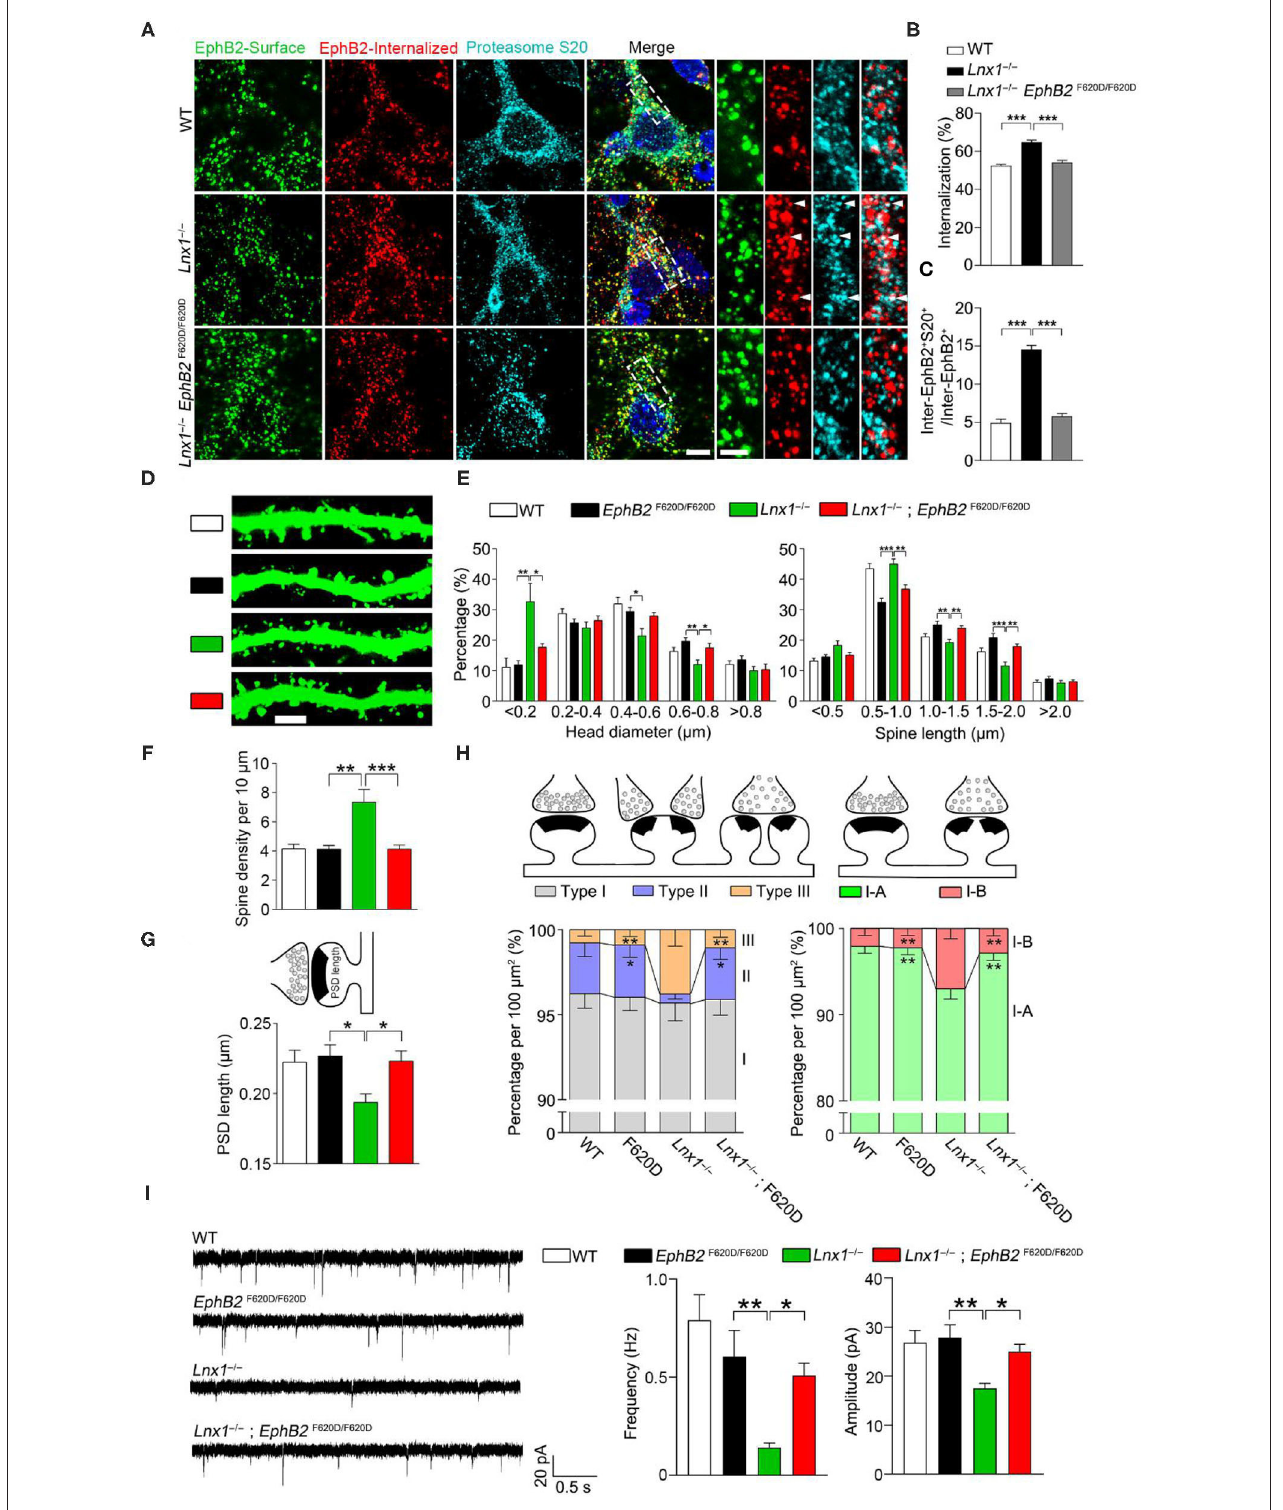
FIGURE 4 | EphB kinase activation promotes synaptogenesis. (A) Internalization of EphB2 receptors and immunofluorescent staining with anti-proteasome S20 in wild-type (WT), Lnx1 − / − , and Lnx1 − / − ; EphB2 F620D / F620D hippocampal neurons. Green, surface EphB2 receptors; red, internalized EphB2 receptors; cyan, proteasome S20. White arrowheads indicate co-localization of internalized EphB2 and proteasome S20. Scale bars represent 5 µ m (left) and 2 µ m (right).